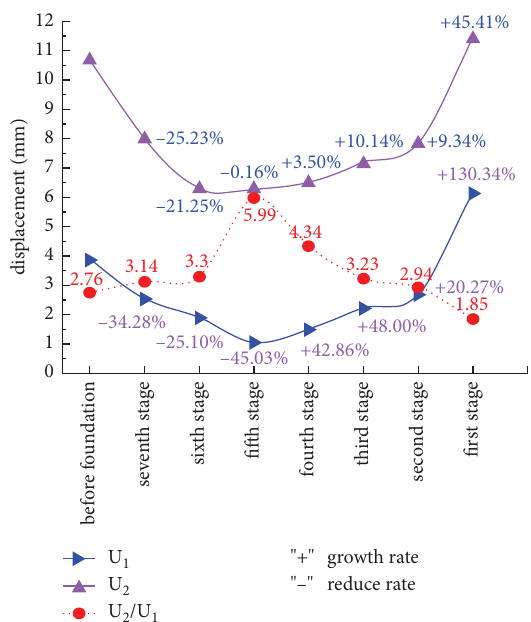
Figure 7: Variation curve of maximum displacement value.